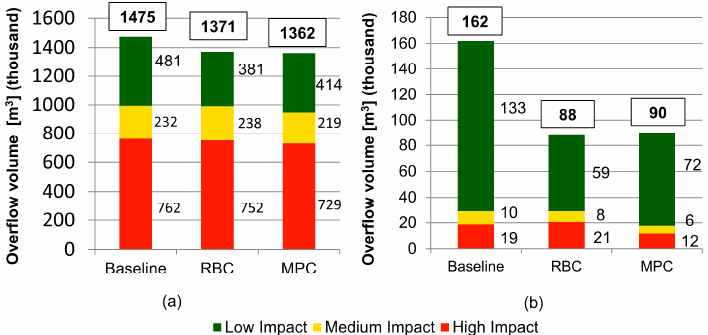
Figure 5. Overflow volumes for the three scenarios depending on the sensitivity of the recipient. The white rectangle above each column shows the total overflow volume for all sensitivity classes. ( a ) All 46 simulated events; ( b ) Events only included with less than 20,000 m 3 of CSO in the baseline scenario. Table 3. Simulated environmental impact risk point (EIRP) values expressed as millions for different environmental impact areas and their relative reduction.